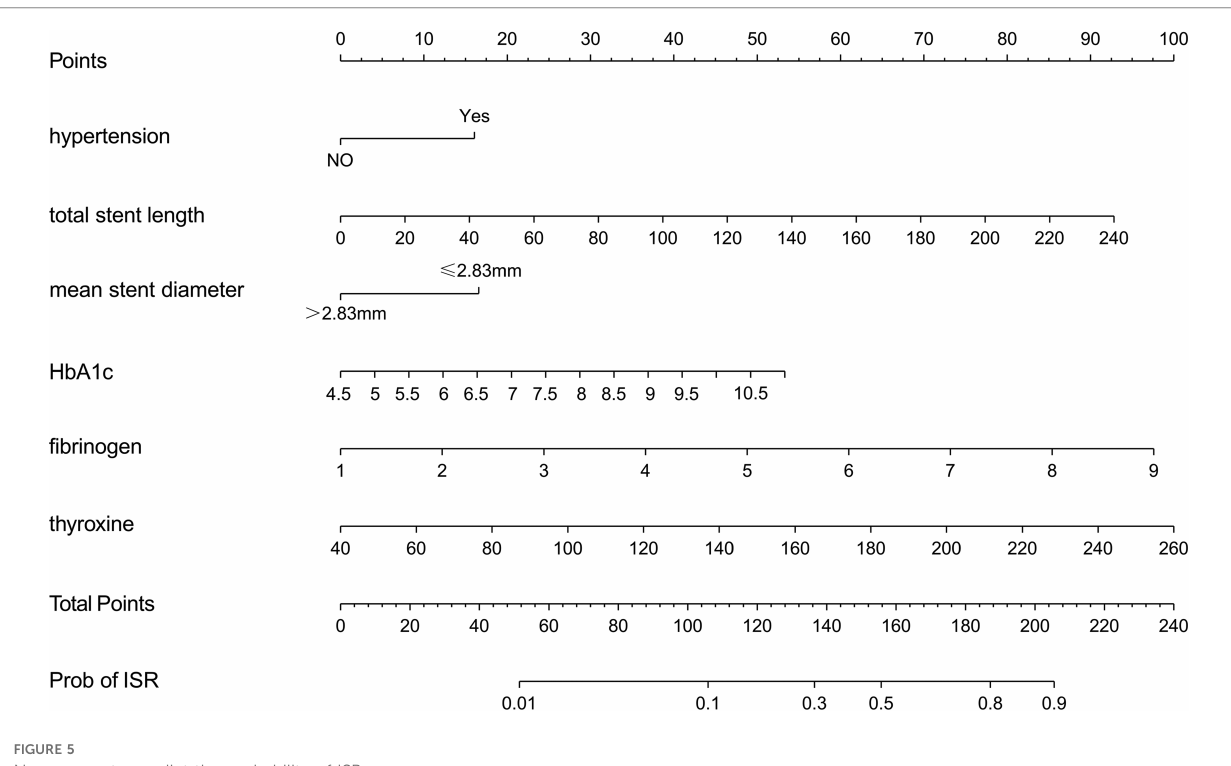
FIGURE 5 Nomogram to predict the probability of